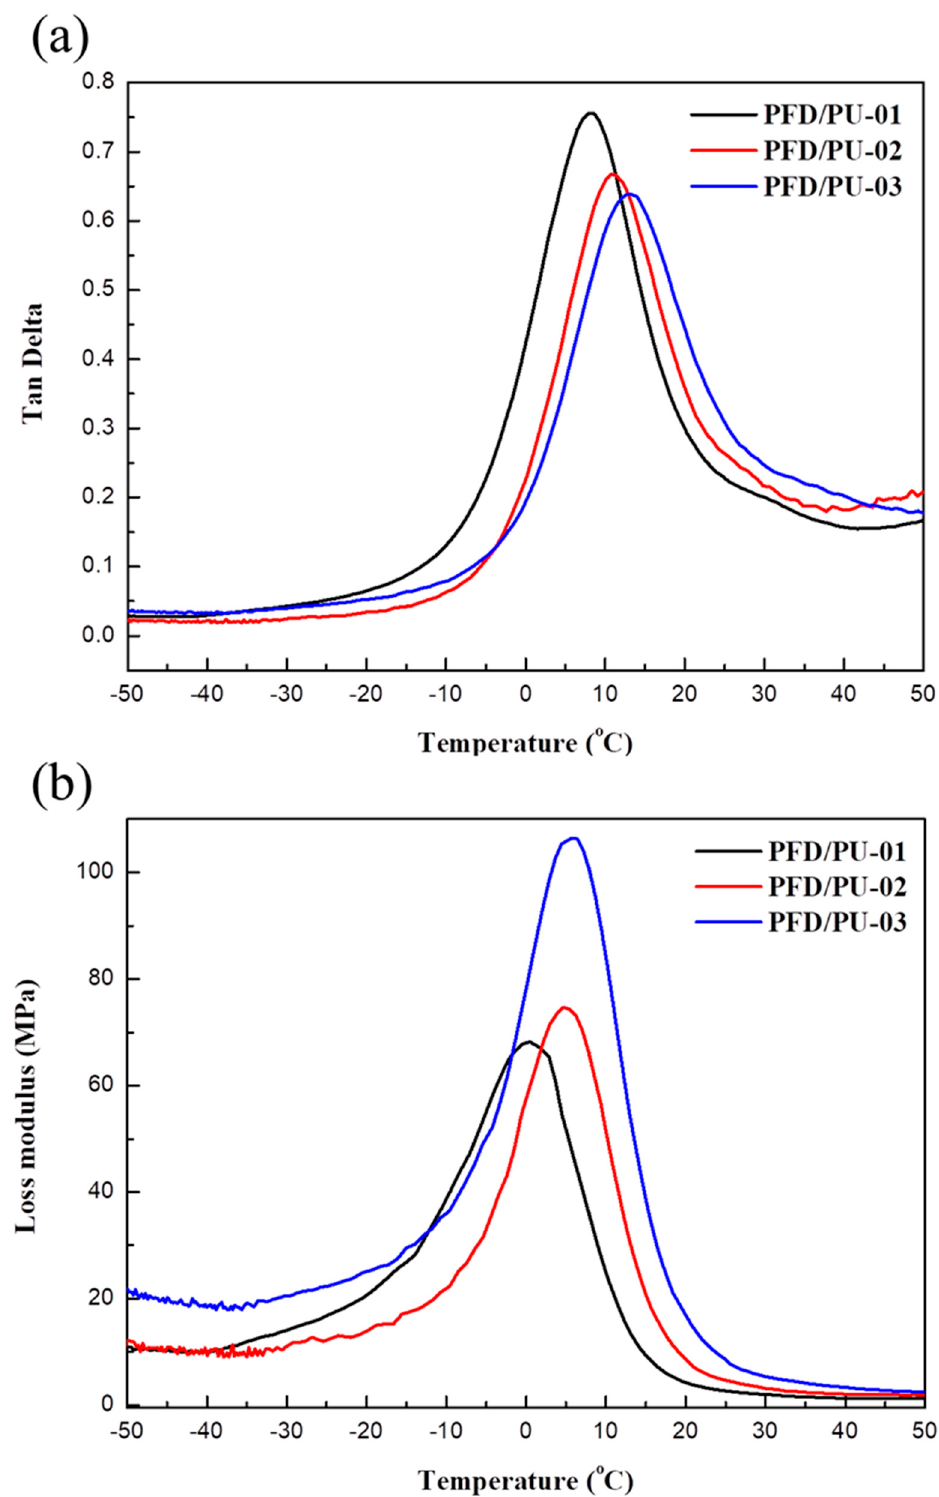
Figure 15. DMA ( a ) tan δ and ( b ) loss modulus (E’’) curves of PFD/PUs.